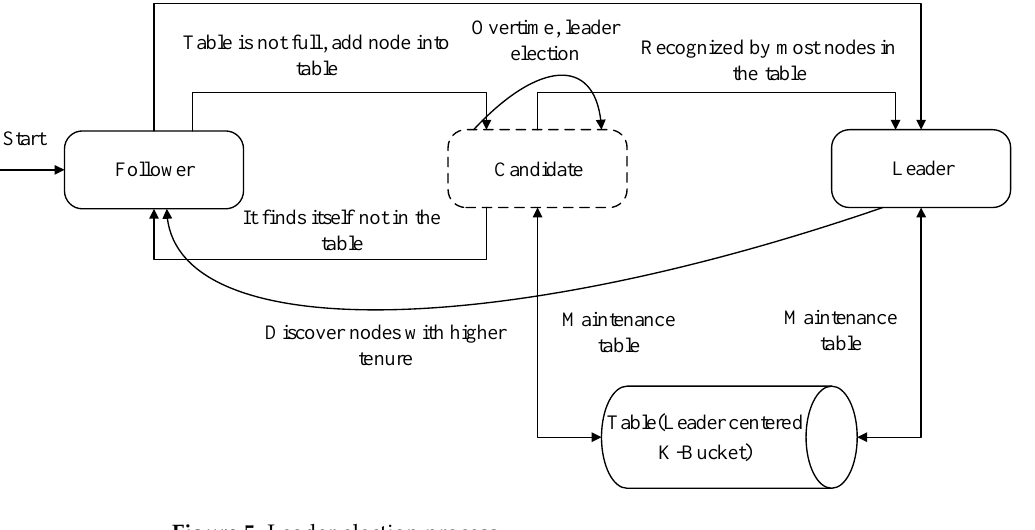
Figure 6. Log replication process. The Leader node sends extra log entries repeatedly to make sure that the log entries stored in the Follower node are consistent with itself and attain a consensus. Log entries will also no longer be synchronized immediately after comments from the Followers node to the Leader node. We should wait for the next round of log entries furnished by means of the Leader node to incorporate confirmation that the Leader node has synchronized the previous round of entries, and then synchronize the entries. In the process of access logging, the Leader node packages the collected access logs into blocks. Once a consensus is reached, the block is added to the blockchain. 6. Security and Performance Analysis 6.1. Scheme Comparison The scheme proposed in this paper is decentralized due to the introduction of the permissioned blockchain. Therefore, it can overcome the single point of failure problem